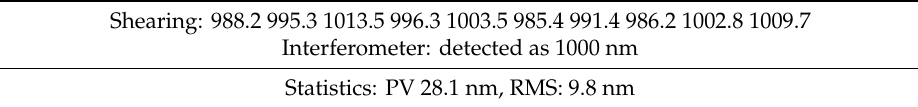
Table 2. Measurement result contrasted with